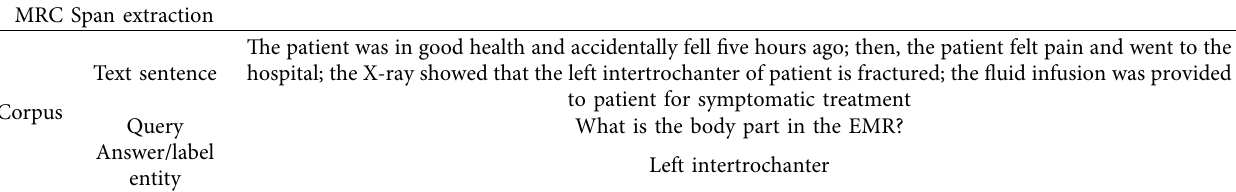
Table 1: Overview of the span extraction task via